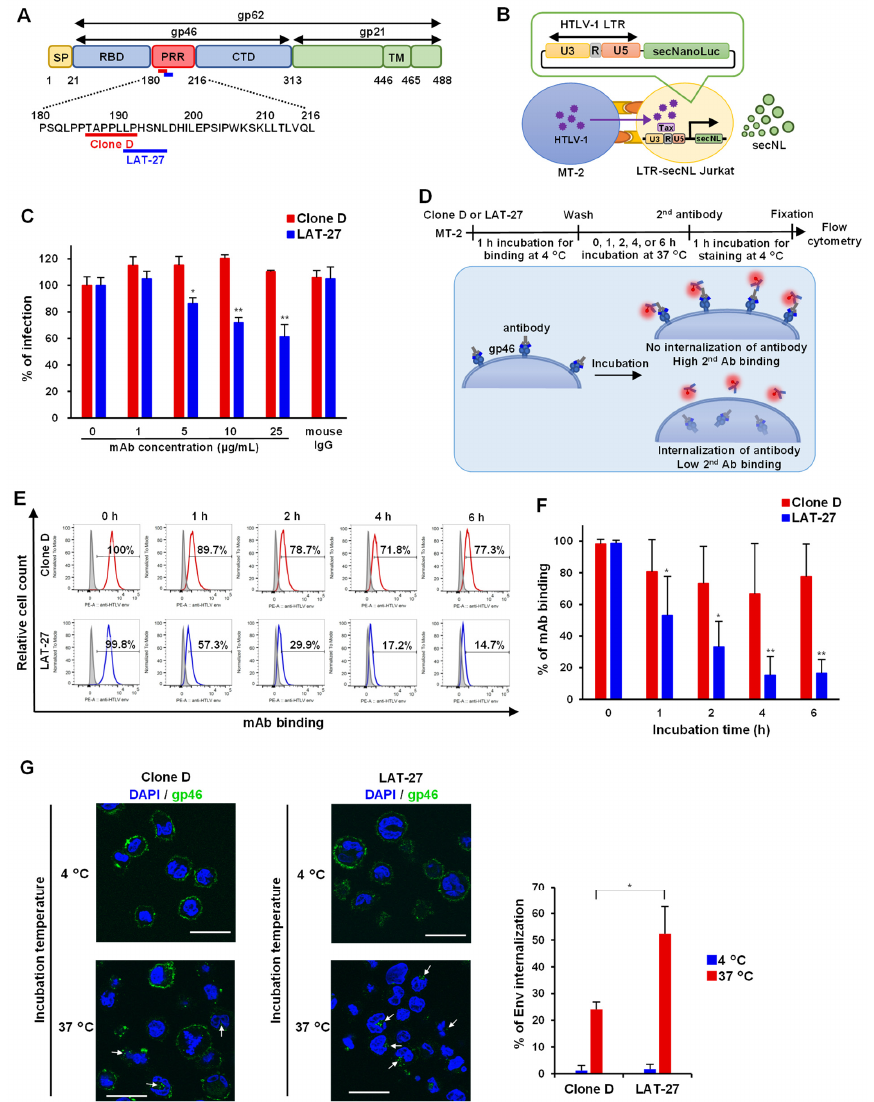
Figure 3. Neutralizing and internalization assays for mAb Clone D and LAT-27: ( A ) an epitope map of HTLV-1 Env gp62, showing the mAb Clone D (red line) and LAT-27 (blue line) recognition sites; ( B ) to establish a reporter assay, LTR-secNL Jurkat cells were generated using a lentivirus. LTR- secNL Jurkat cells were co-cultured with MT-2 cells infected with HTLV-1 and secretion of NanoLuc induced by virus-derived Tax protein; ( C ) the neutralization assay was performed by incubating MT-2 cells with Clone D and LAT-27, mixing them with LTR-secNL Jurkat cells and collecting the supernatant after 48 h. The result shows the percentage of infection when the infection rate at 0 μ g/mL of mAb concentration is 100%. Mouse IgG (25 μ g/mL) was used as a negative control. Error